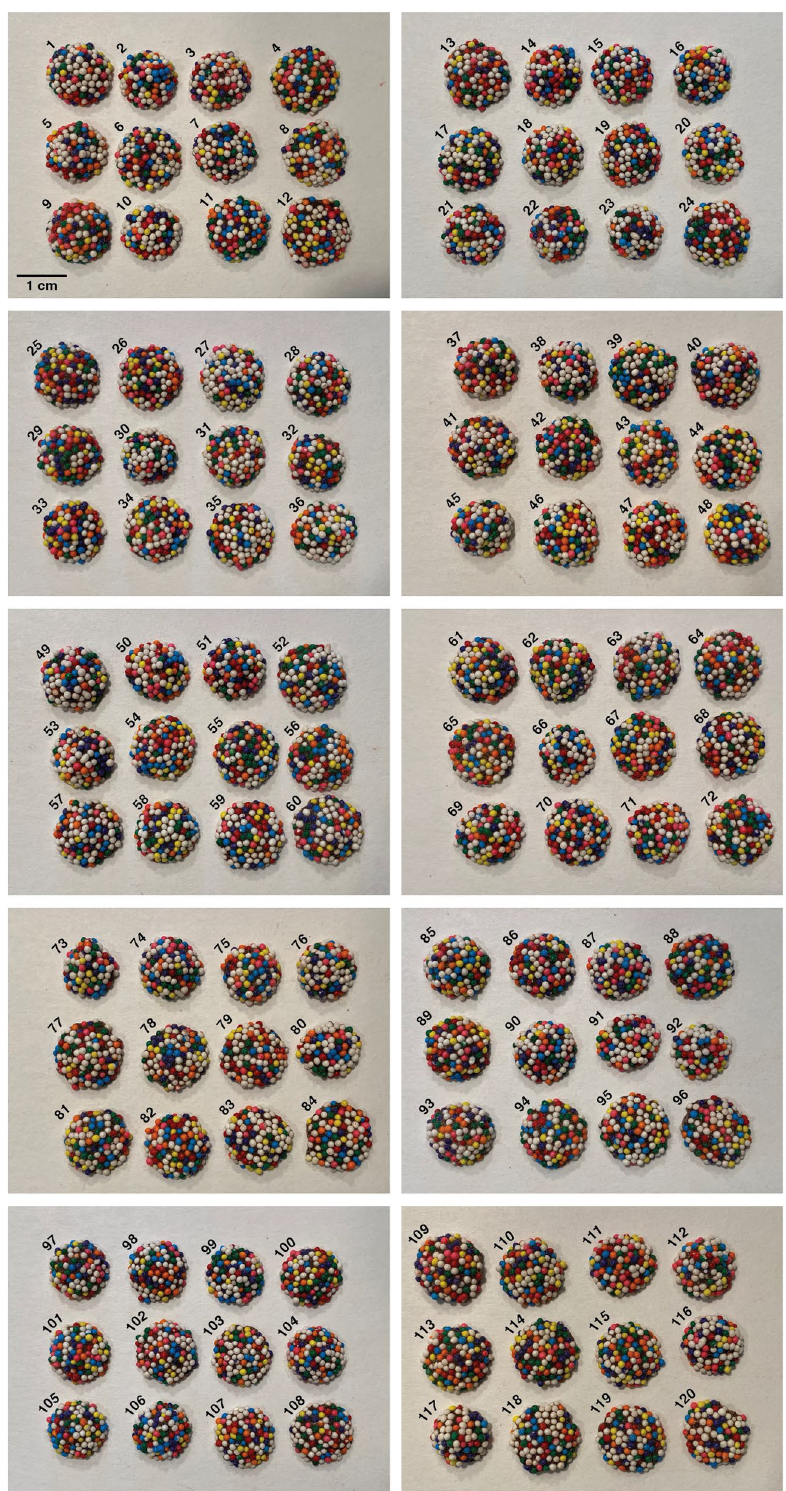
Figure 3. Photographs of 120 candies used to create a test library of CandyCodes. These commercially produced candies were used as proxies for actual CandyCoded medications. Each chocolate candy is coated by the manufacturer with an eight-color mixture of nonpareil spheres; the candies shown here received between 72 and 108 nonpareils each, with an average of 92.6 nonpareils per candy. Each CandyCode photo was converted to a set of strings using the process described in Fig. 4 and analyzed to determine its uniqueness. Additionally, three of these CandyCodes (numbers 103, 104, and 109) were selected at random and subjected to one week of physical abuse to determine if mechanical wear sustained during shipping could affect the information content of